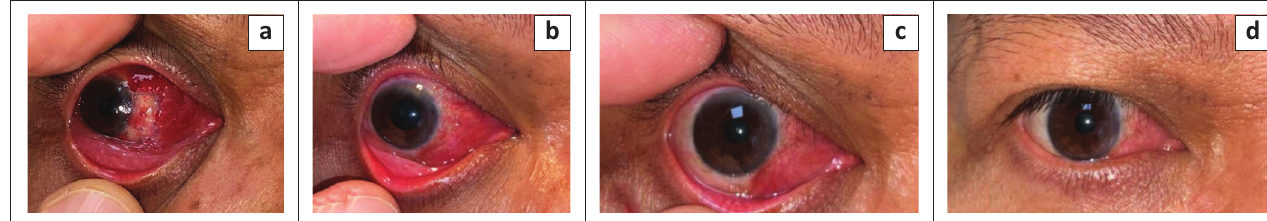
FIGURE 3: Treated pterygium (right eye) showing: (a) one week postoperative with grade 4 conjunctival hyperaemia; (b) one month postoperative with grade 4 conjunctival hyperaemia; (c) and (d) at the end of follow-up with moderate (grade 3) nasal conjunctival hyperaemia.